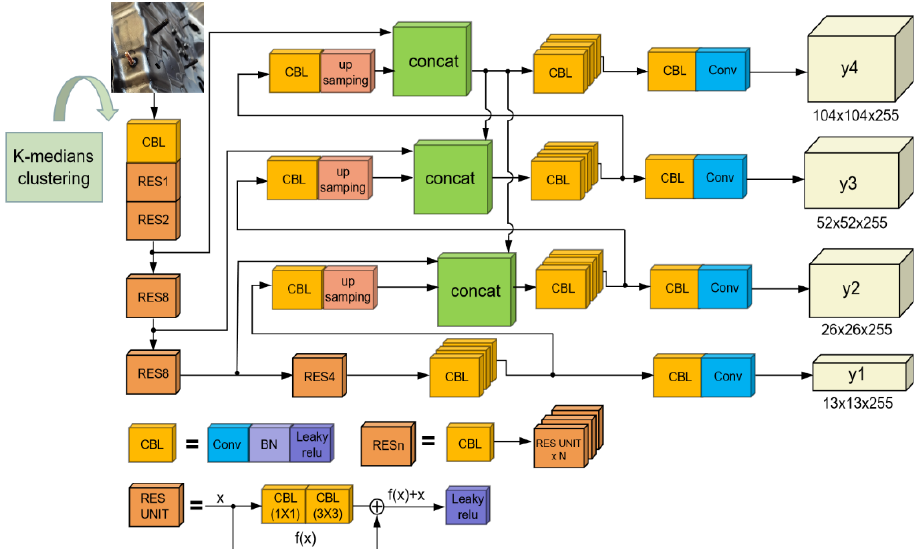
Figure 2. Improved YOLOv3 algorithm network structure.